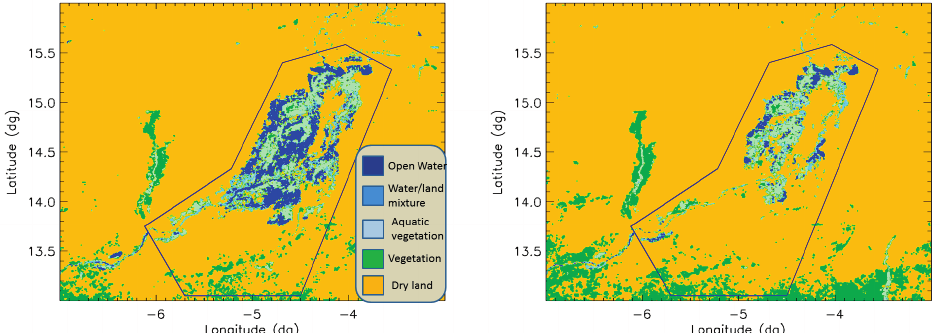
Figure 6. Map of Moderate Resolution Imaging Spectroradiometer classification for the day of maximum inundation for 2001 (high inundation) and 2002 (low